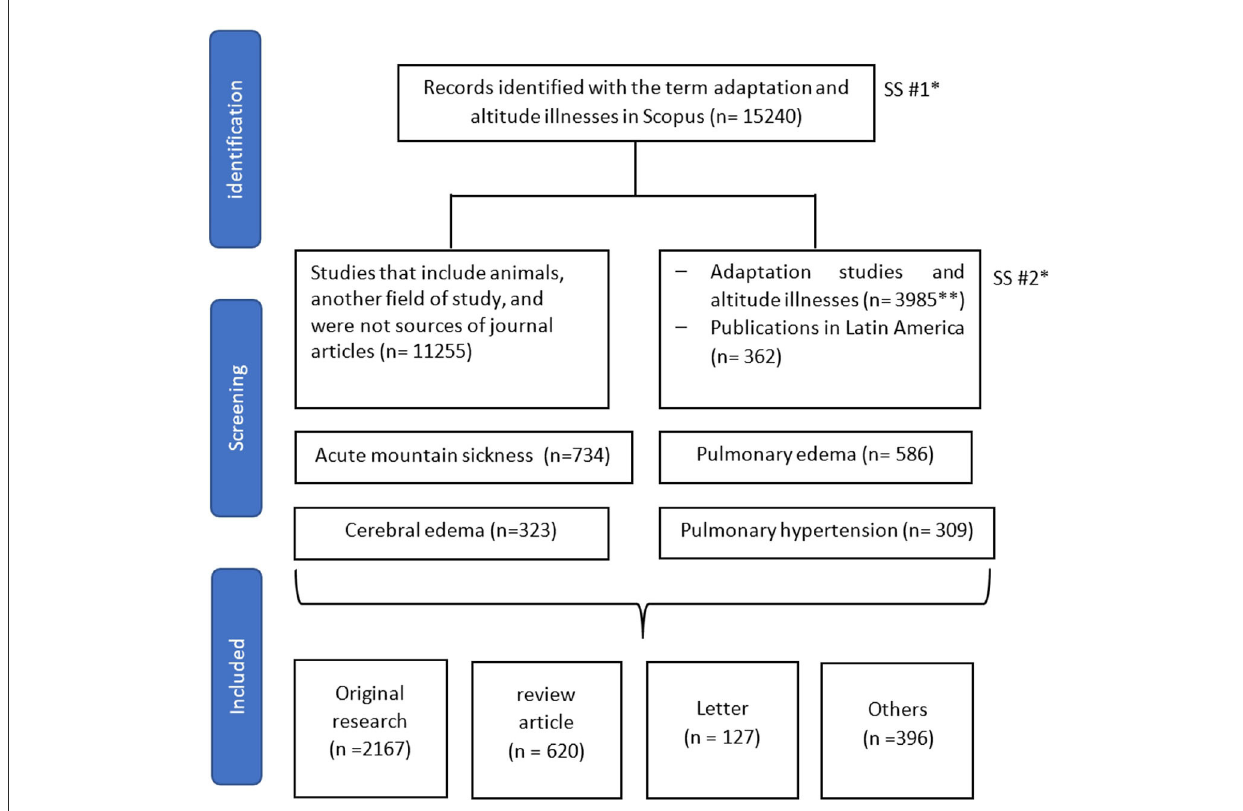
FIGURE1 Flowchart of study selection. *SS: Search strategy; **Medicine, Nursing, Dentistry, Health professions.